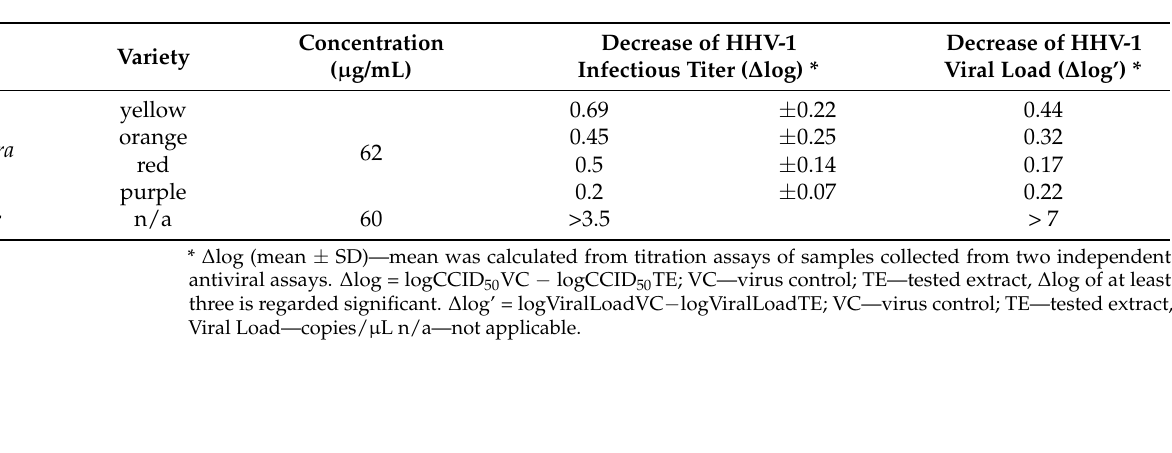
Figure 5. The effect of P. grandiflora extracts on HHV-1-related CPE. Table 5. The reduction of HHV-1 infectious titer and viral load by P. grandiflora